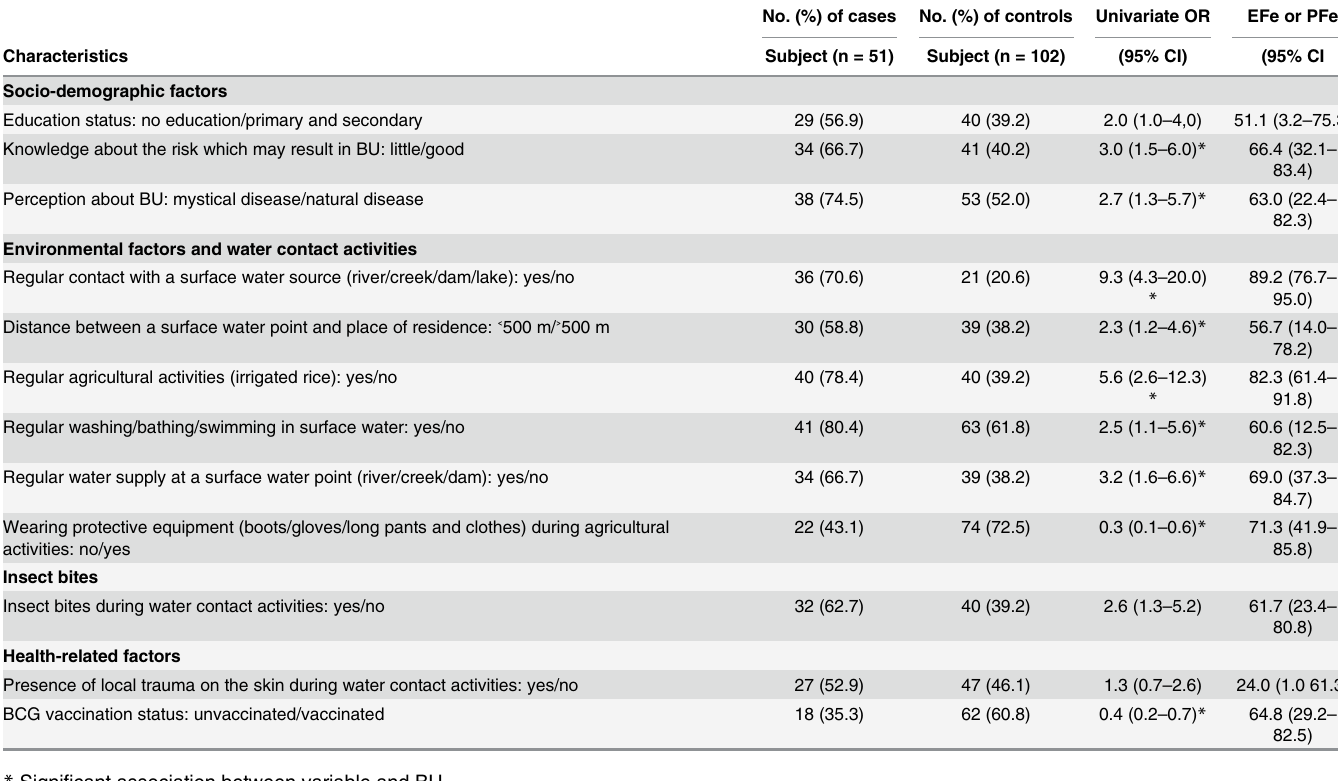
Table 2. Univariate analysis of selected variables for BU in the district of Tiassalé, south Côte d'Ivoire (case-control study, August-September 2012).